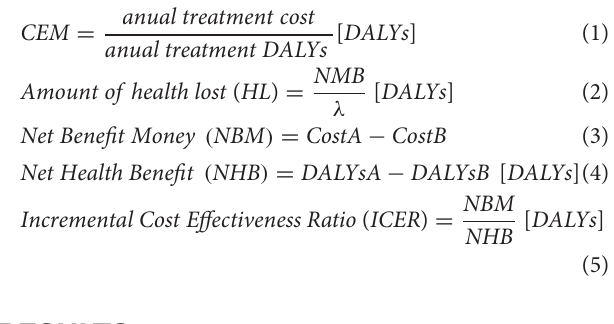
(29). Later, we calculate the probability of density (which means adopting the cost–utility measurements affect the